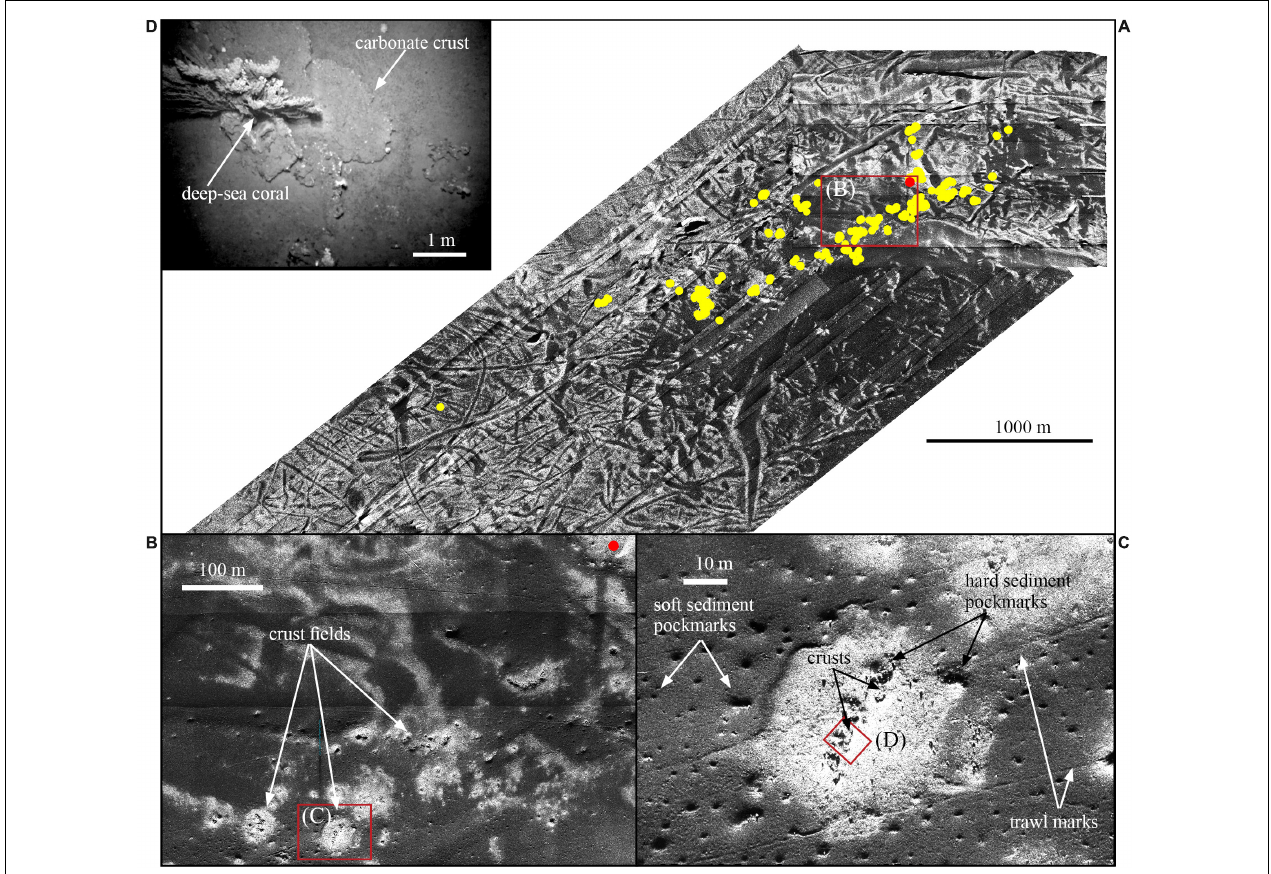
FIGURE 8 | (A) SAS imagery of Area 2 with one gas flare (red dot), carbonate crust fields (yellow dots). High backscatter – light tones, low backscatter – darker tones. Red rectangle shows inset map B. (B) SAS imagery showing carbonate crust fields. Red rectangle shows inset map C. (C) Zoomed in map showing individual crusts, pockmarks and trawl marks. Red rectangle shows photo D. (D) TFish photo of carbonate crusts and a deep-sea coral (possibly Paragorgia).